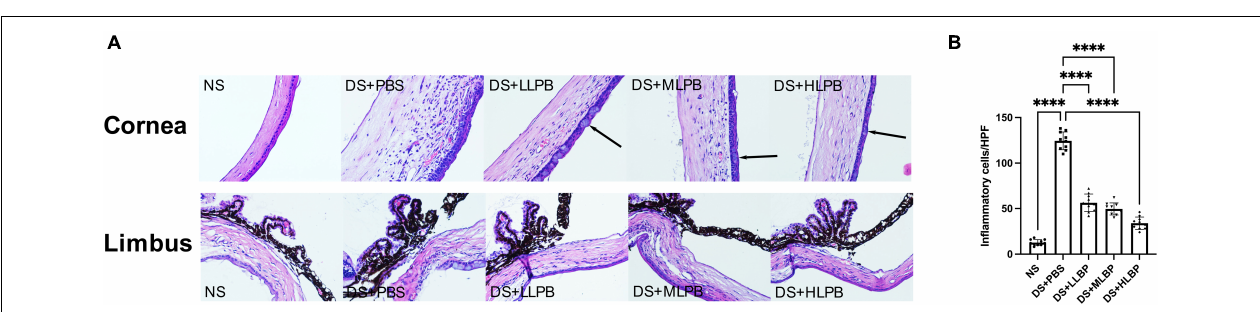
FIGURE 3 | (A) Representative images of H&E staining in the cornea and limbus of different groups on days 10 after treatment. The arrows showed corneal conjunctivization (magnification: 40 × ). (B) The inflammatory cell count in the cornea and limbus of different groups on days 10 after treatment. ∗∗∗∗ P <